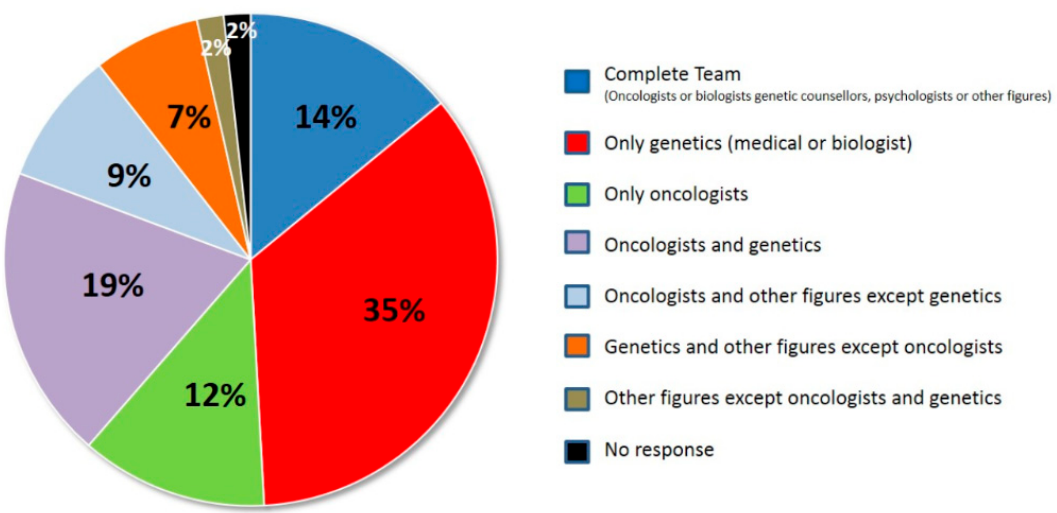
Figure 1. Professionals working within the team of the genetic counseling office.